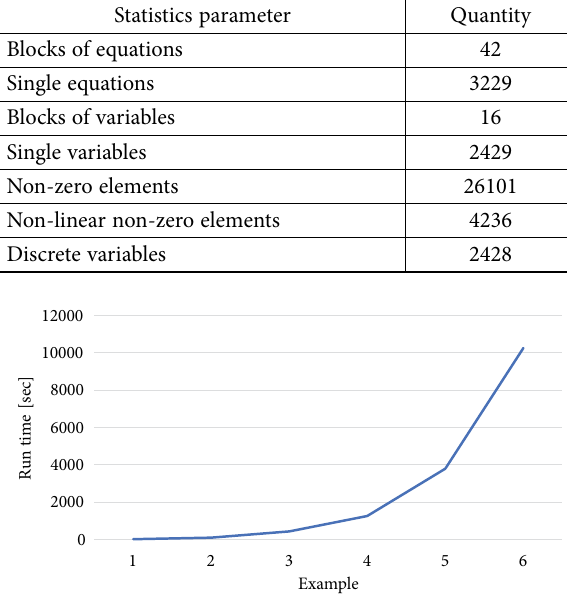
Figure 2. The trend of solving run time with increasing the